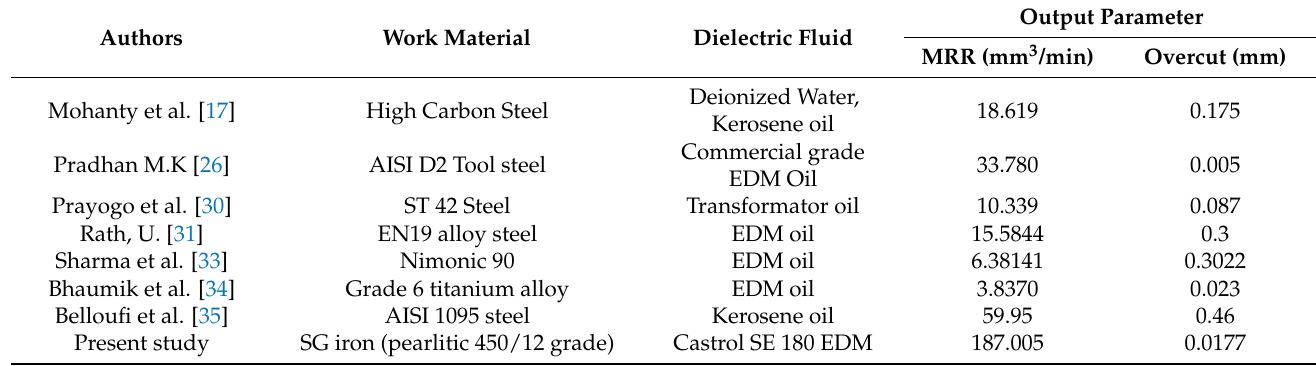
Table 12. Results reported by past researchers and present study for different work material and dielectric fluid